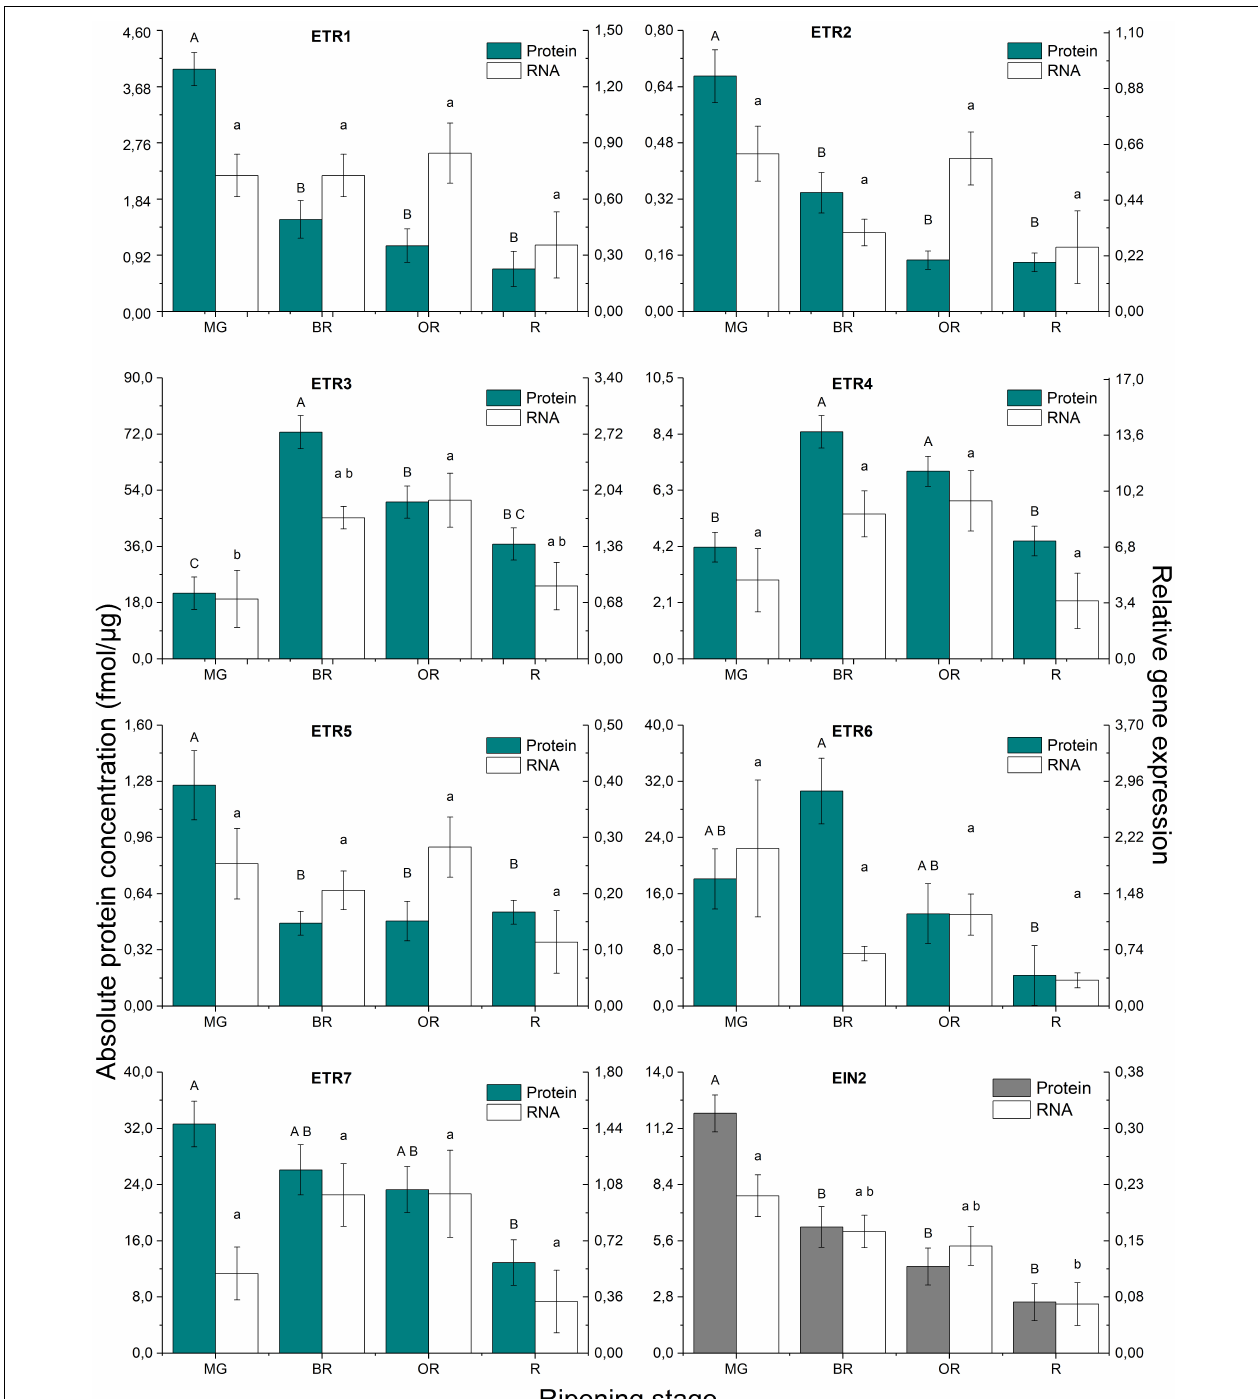
FIGURE 3 | Absolute protein quantification (fmol of target protein/ µ g of total membrane proteins) and relative gene expression of ETR1-ETR7, and EIN2 during tomato fruit ripening. MG, mature green; BR, breaker; OR, orange; R, red tomatoes. Error bars represent the standard error of the mean based on six biological replicates. Difference uppercase letters indicate significant differences between the absolute protein concentration levels of the four tomato ripening stages determined by Tukey’s HSD test ( p < 0.05). Different lowercase letters indicate significant differences between the relative gene expression levels of the four tomato ripening stages determined by Tukey’s HSD test ( p <